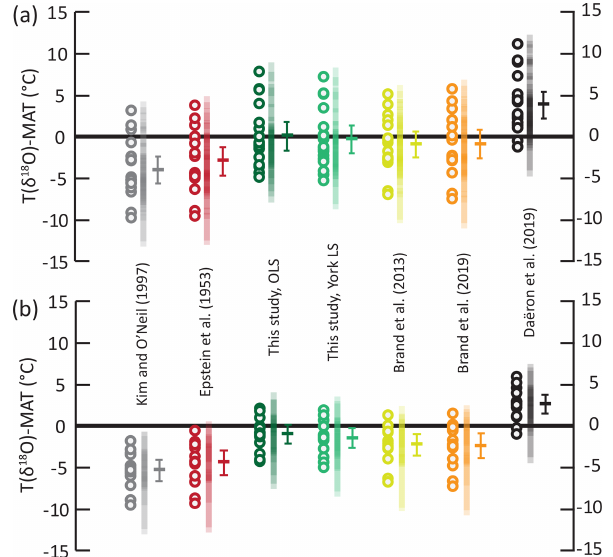
Figure 3. Offsets between the δ 18 O temperatures and MAT from the modern-brachiopod dataset of Bajnai et al. (2018) using different fractionation equations. Circles: temperature offset for each sample; vertical transparent bars: temperature offset 95% confidence inter- val for each sample; horizontal bar: temperature offset arithmetic mean and associated 95% confidence interval of the mean. (a) Tem- perature offset for isotopic temperatures calculated with δ 18 O sw values calculated from the LeGrande and Schmidt (2006) database; n = 18. (b) Temperature offset for isotopic temperatures calculated with locally measured δ 18 O sw values; n = 13. OLS refers to or- dinary least-squares regression; YLS refers to York least-squares regression (York et al.,